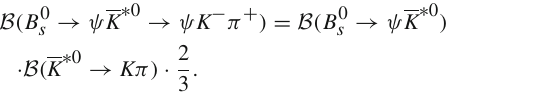
Table 6 Branching ratios of the quasi-two-body decays B 0 s → ψ( 3686 ) K ∗ 0 ( → K − π + ) under the 2S–1D mixing mechanism calcu- Decay